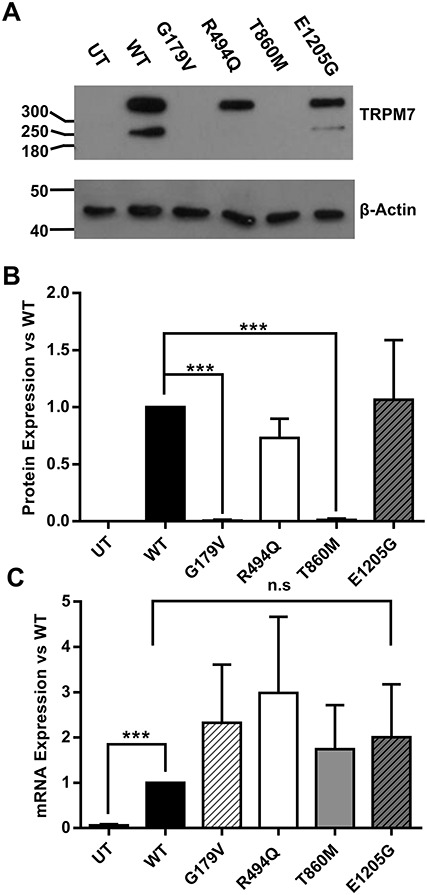
Stillbirth variants p.G179V and p.T860M reduce TRPM7 protein levels but leave transcription unchanged. (A) Whole cell lysates from HEK293 cells transiently transfected with wild-type TRPM7 and mutant vectors. PVDF membranes were initially blotted with anti-TRPM7 before stripping and reprobing with anti-β-actin. (B) Quantification of three western blots from whole-cell HEK293 lysates transfected with WT or stillbirth variant TRPM7 normalised to loading β expression before normalising to WT expression. C qPCR expression of TRPM7 from transfected cell lysates normalized to WT. Lysates were treated with DNase I for 15 minutes at room temperature before qPCR analysis. WT = wild-type, UT = untransfected. ***P < 0.001 vs WT.